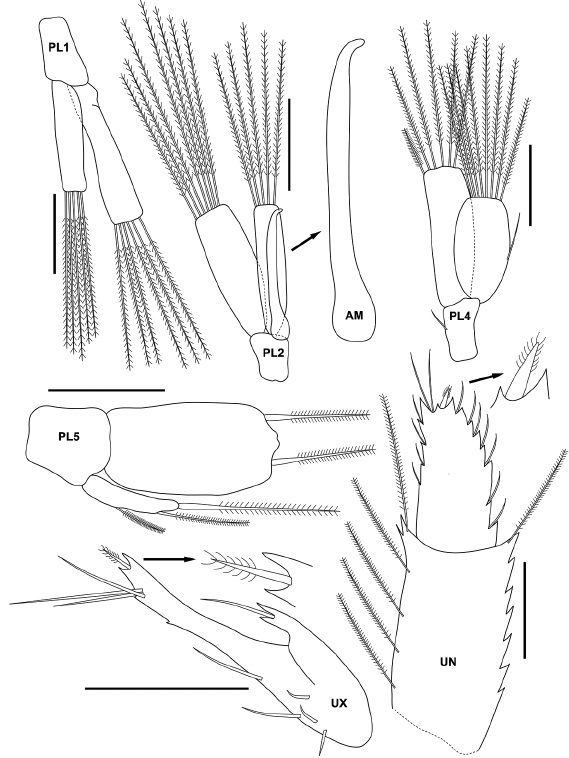
Figure 5. Eisothistos tiomanensis sp. n. All scales represent 0.1